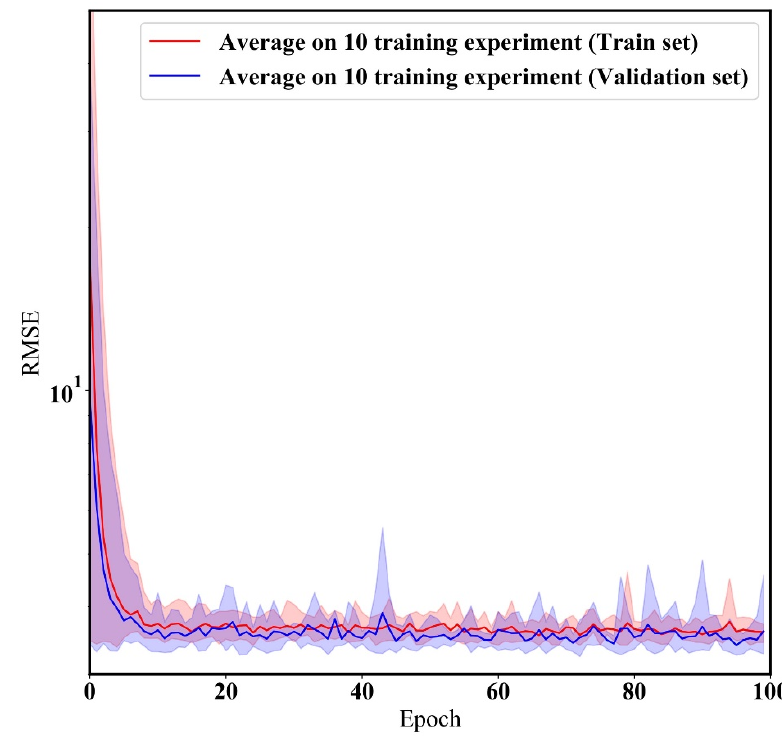
Figure 6. Results of robust model test. The robust test is performed on 10 repeated training exper-